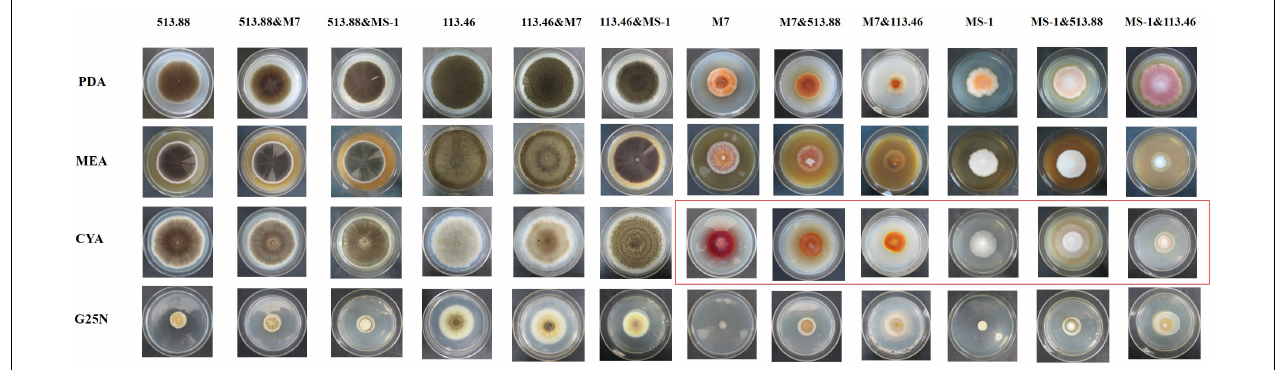
FIGURE 5 | Colonial morphologies of Monascus ruber M7, Monascus pilosus MS-1 when co-cultured with Aspergillus niger CBS 513.88 and A. niger CBS 113.46 by using DSPD at 9 days. M7- M. ruber M7; MS-1- M. pilosus MS-1; 513.88- A. niger CBS 513.88; 113.46- A. niger CBS 113.46; &-co-cultured with.